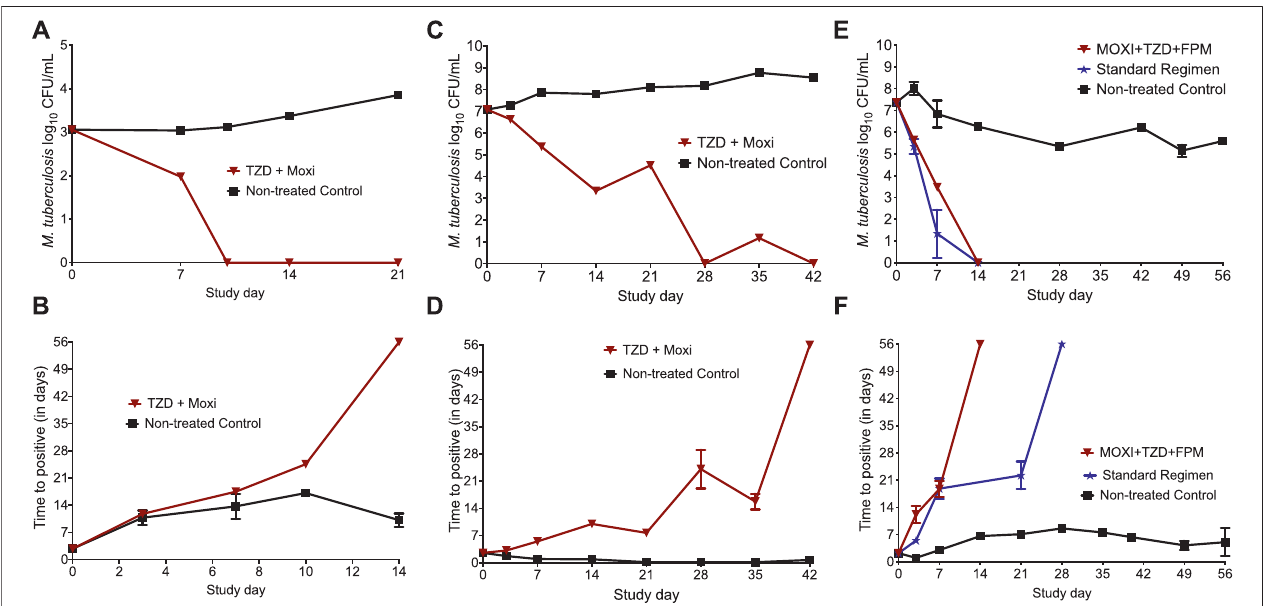
FIGURE 1 | Changes in the bacterial burden in the HFS-TB treated with different treatment regimens. The data point is presented as mean ± standard error. In the bactericidal activity study, total microbial kill was recorded by both (A) CFU and (B) TTP measures in 14 and 10 days, respectively. In the HFS-TB experiment with